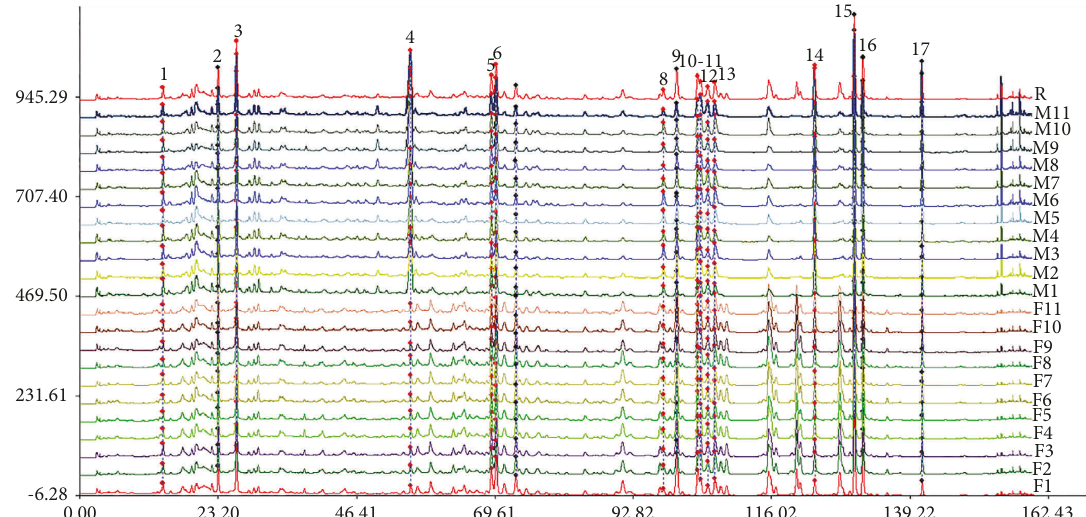
Figure 2: HPLC fingerprints of MFB and FFB of P. tomentosa . F1–F11 are female flower bud samples. M1–M11 are male flower bud samples. R refers to the control fingerprint. The X axis refers to the retention time (t/min). The Y axis refers to the response value (mAU). The peaks 1–17 are the main common peaks.